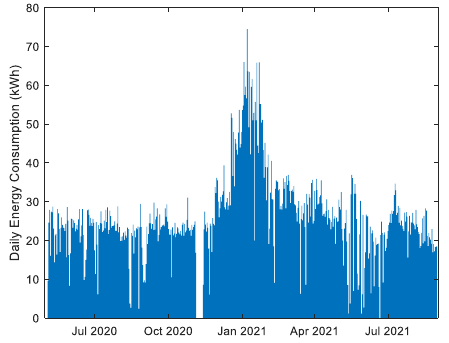
Figure 3. Daily energy consumption.